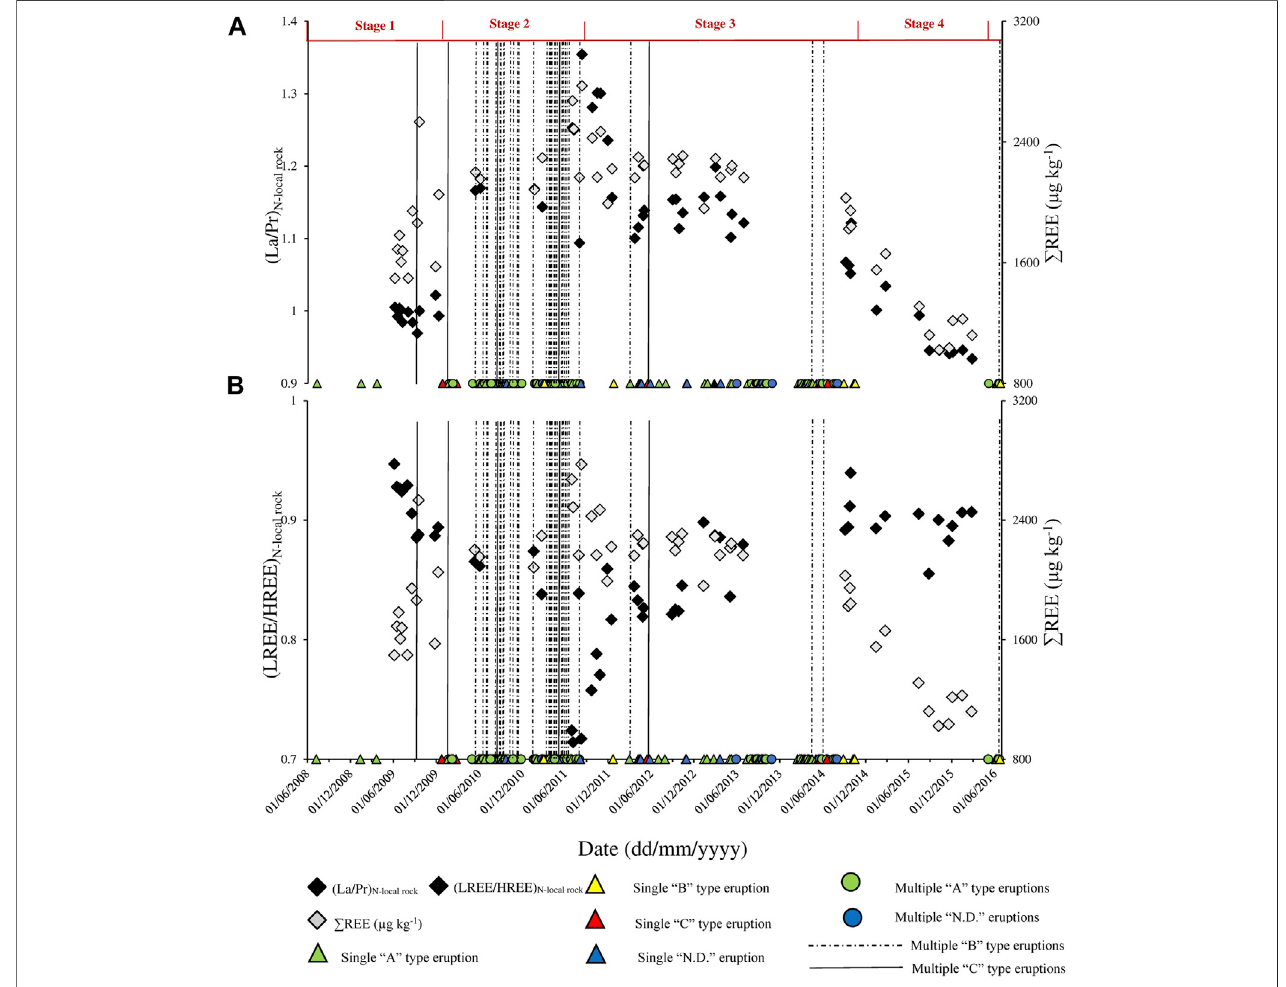
FIGURE 3 | (A) (La/Pr) N-local rock and (cid:1) REE vs. time. (B) (LREE/HREE) N-local rock and (cid:1) REE vs. time.